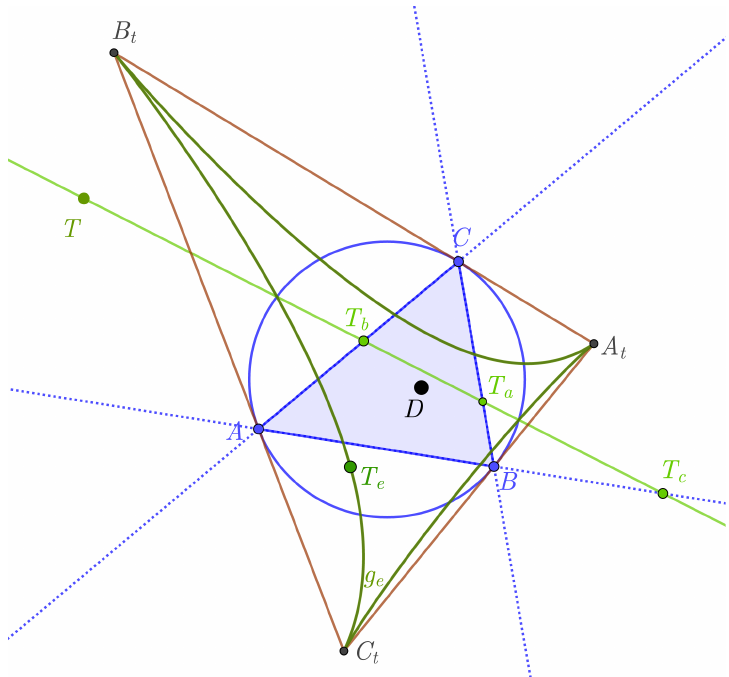
Figure 4. Exeter transformation of the line g